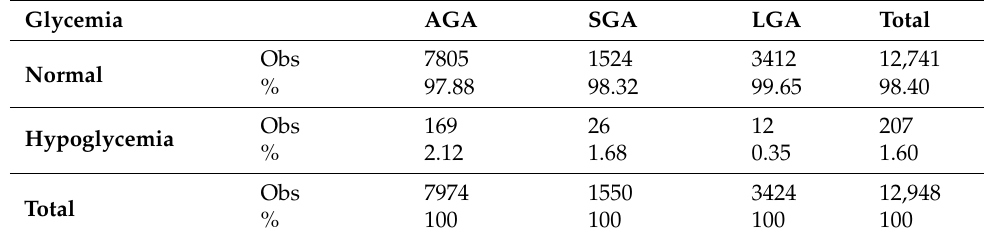
Table 5. Association between weight for GAs and blood glucose alterations in patients in intermittent feeding. AGA, appropriate for gestational age; SGA, small for gestational age; LGA, large for gestational